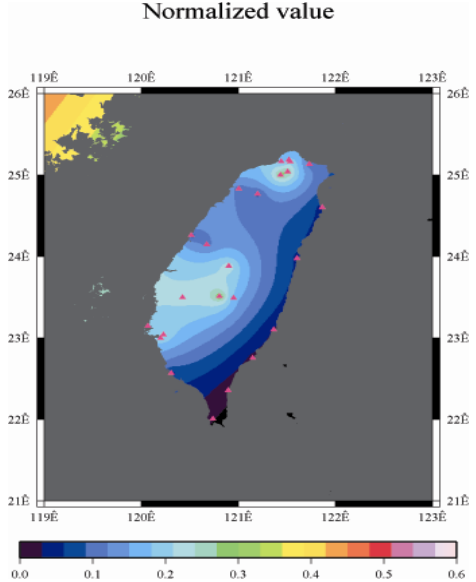
Figure 15. Normalized rainfall values around the island when the typhoon was striking Taiwan (September 14th, 2008, 1:00 PM).